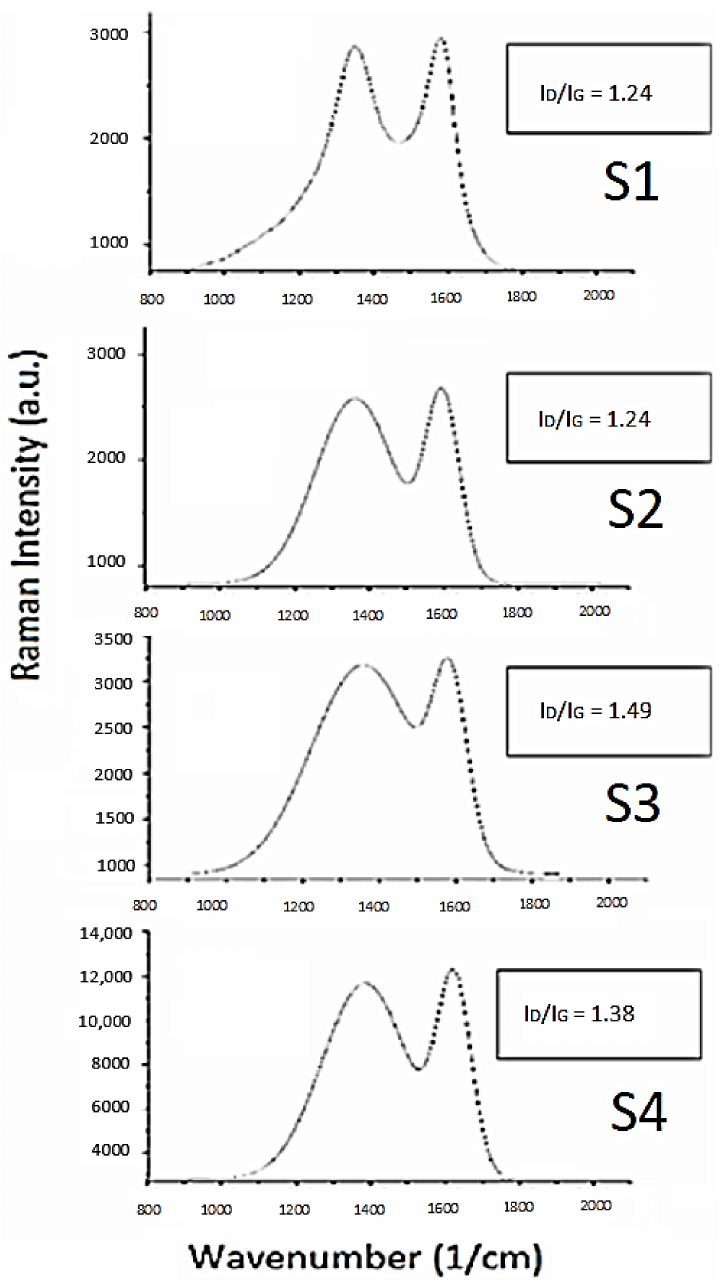
Figure 2. Raman spectra for soy